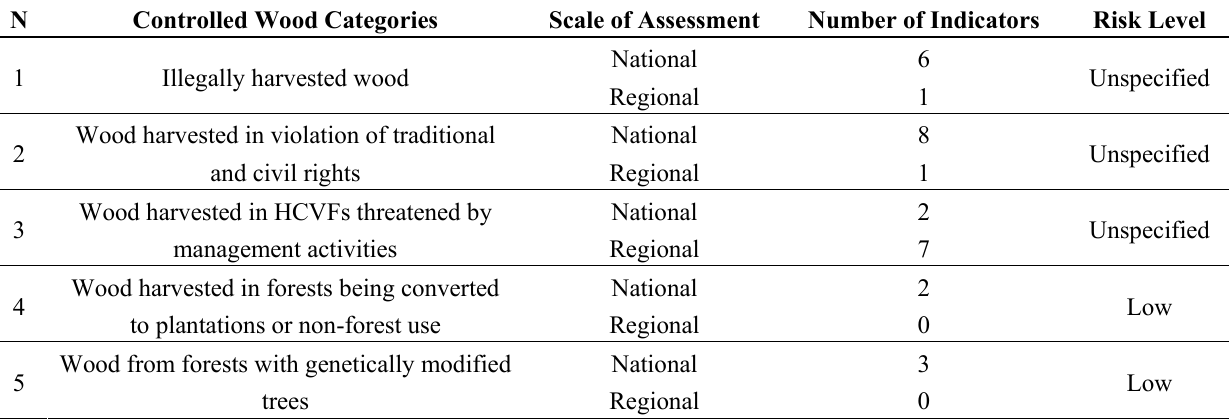
Table 9. FSC Controlled wood risk assessment for the Russian